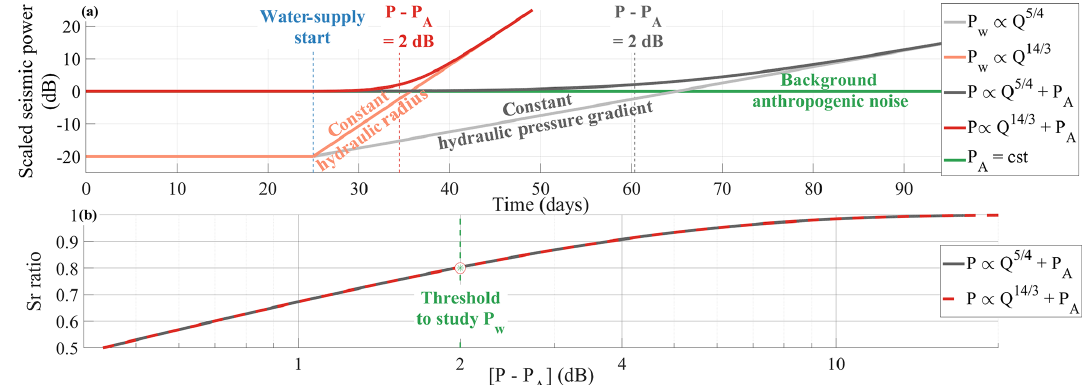
Figure 3. Synthetic predictions of scaling bias due to anthropogenic noise superimposing on subglacial channel-flow-induced seismic noise. (a) Synthetic anthropogenic seismic power (green line; P A ), synthetic subglacial channel-flow-induced seismic power P w = Q n , with Q being the synthetic water discharge for n = 5 (grey line) and n = 14 (orange line) and synthetic seismic power P = P A + P w for n = 5 4 3 4 (red line). (b) Evolution of S r (see Sect. 4.2) ratio with respect to P - P A for n = 5 (grey line) and n = 14 (red line). (black line) and n = 14 3 4 3 Note that the two curves